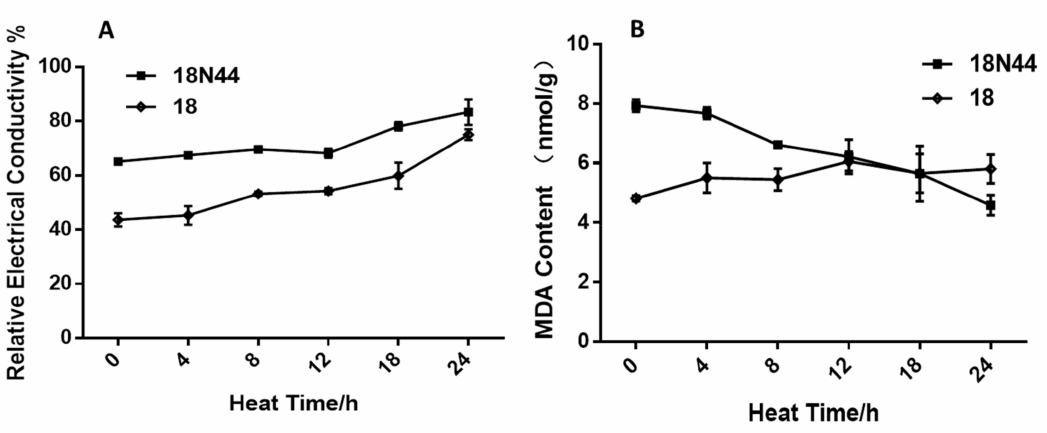
Figure 2. Determination of physiological indices of L. edodes mycelium under high stress. ( A ) Change in the mycelial conductivity of L. edodes under high stress. ( B ) Changes in the malondialdehyde (MDA) content of L. edodes after heat stress. The values are the means ± SD of three independent